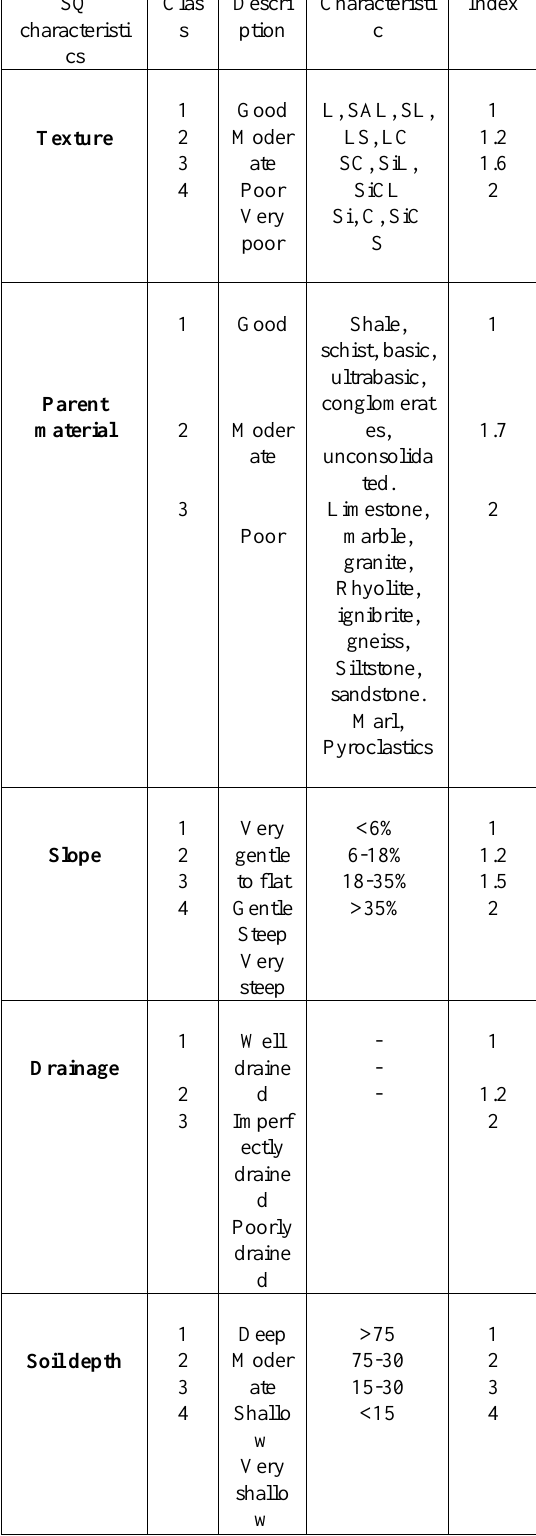
Table2. Classes, and assigned weighing indices for the various parameters used for soil